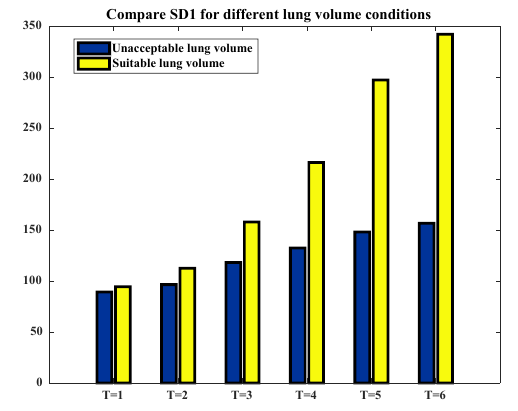
Fig 6. Comparison of the SD1 parameter for different value of the τ.